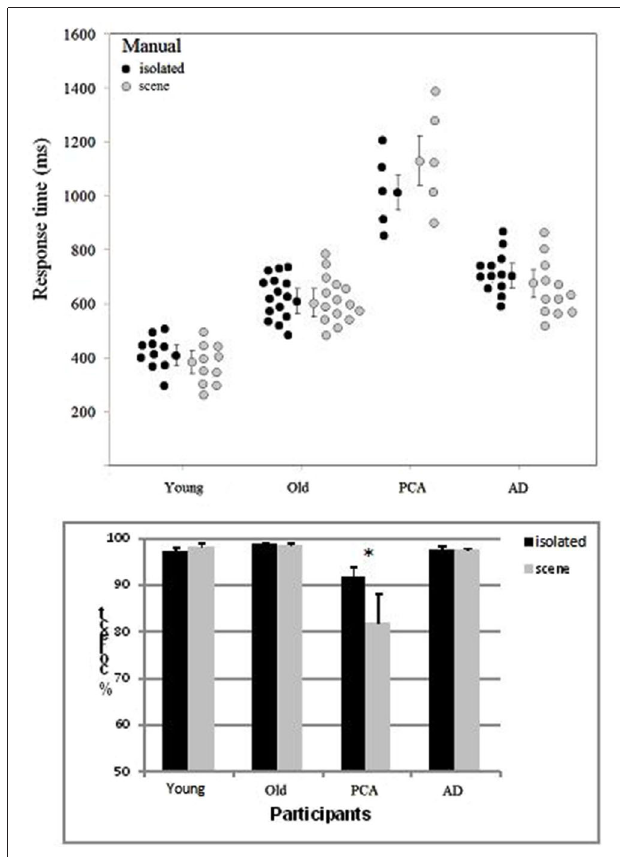
FIGURE 3 | Distribution of the mean manual RT (with each group’s median and standard error) and accuracy (with the standard error) as a function of group (young adult controls, elderly adult controls, patients with AD and patients with PCA) and the type of image (isolated targets vs. targets in scenes)